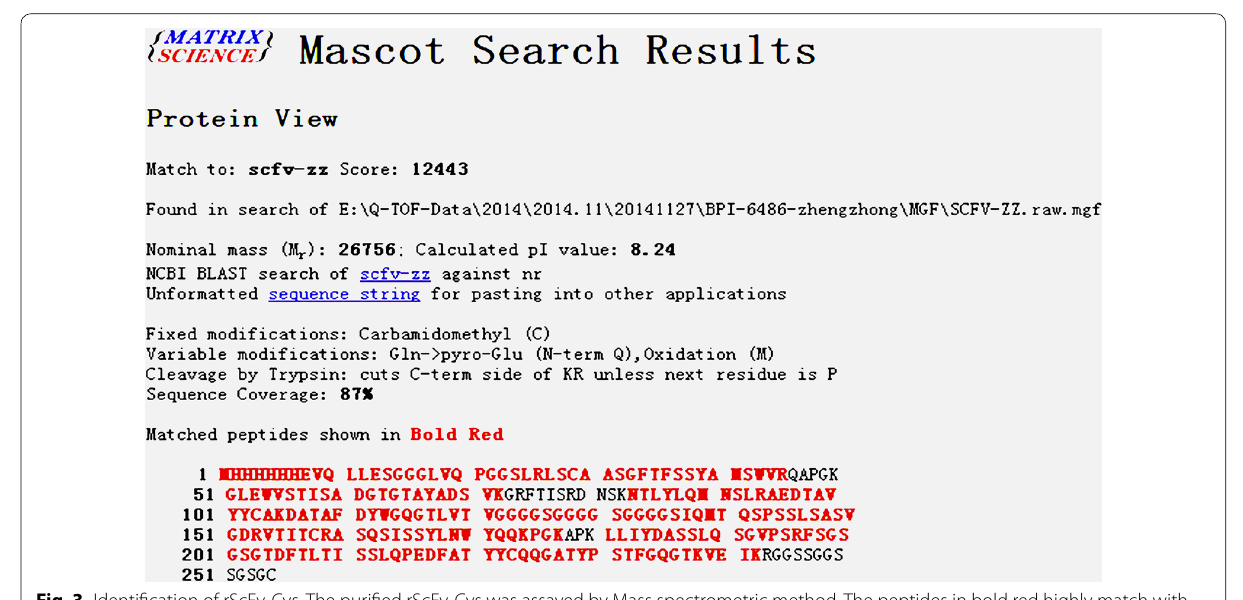
Fig. 3 Identification of rScFv-Cys. The purified rScFv-Cys was assayed by Mass spectrometric method. The peptides in bold red highly match with rScFv-Cys, in which its sequence coverage reaches